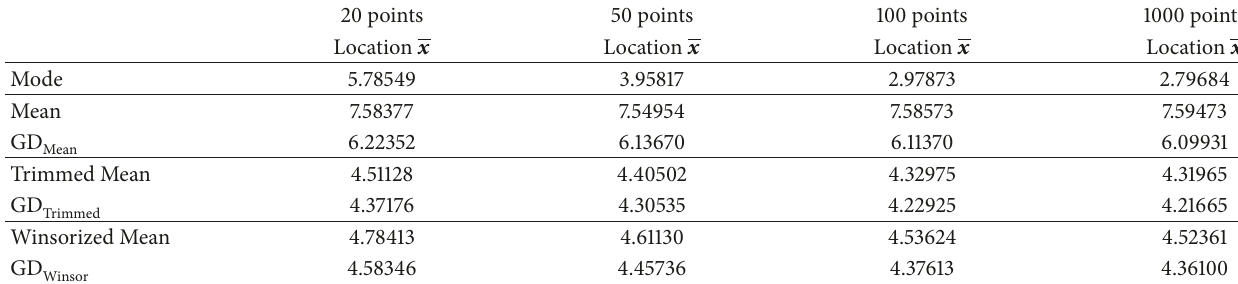
Table 42: Contaminated 𝜒 2 distributions with 30% noise level.